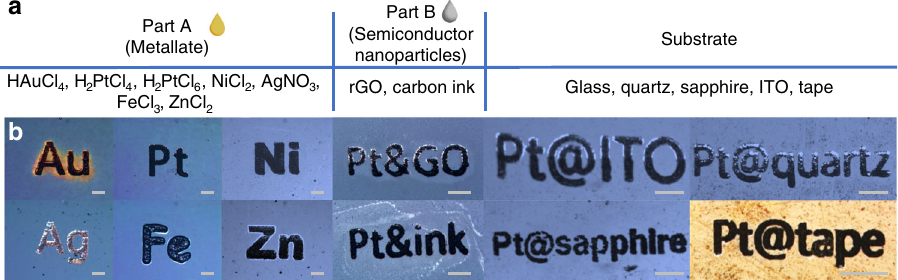
Fig. 2 Material depositions with the LIMD method on various substrates. a list of the ingredients and substrates used by the LIMD method in this work. b re fl ection type illumination microscopic images of different materials deposited on substrates. Except for the fourth one from the left in the upper row, which was done with reduced graphene oxide as Part B, the rest were done with carbon ink. Energy-dispersive X-ray (EDX) spectroscopy data, which show the element compositions in the layer are available in Supplementary Information. The grey scale bars represent 50 μ